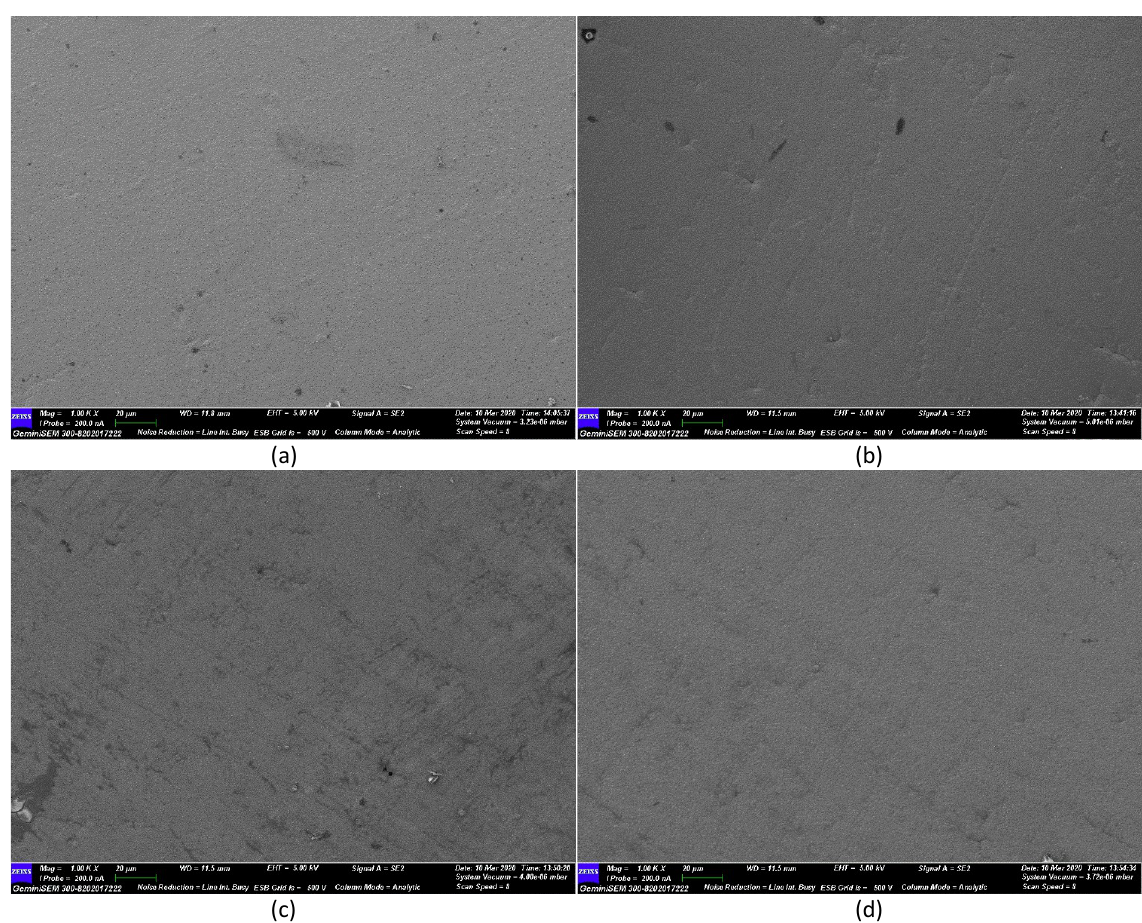
Fig.3 . Ni-Cr alloy coating microstructures for varying plating current densities: a) 2 A/dm 2 , b) 4 A/dm 2 , c) 6 A/dm 2 and d) 8 A/dm